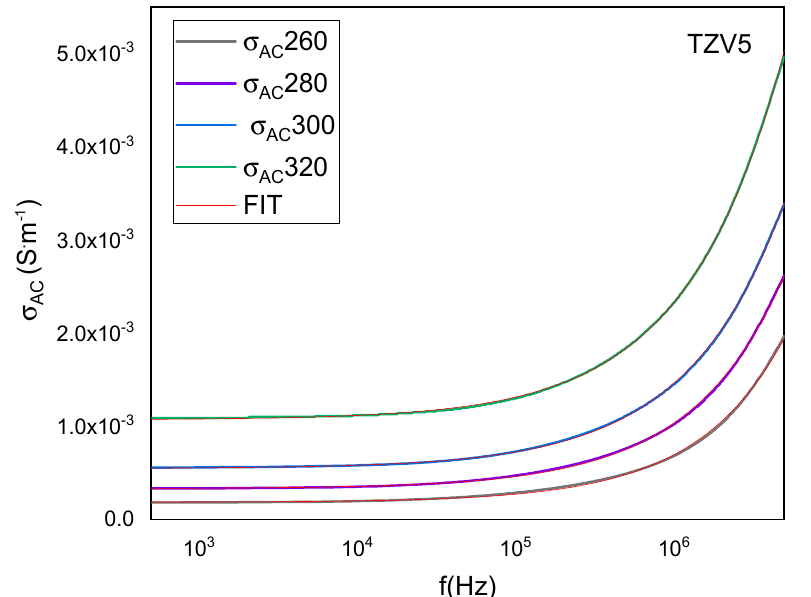
Figure 10. Variation versus frequency of the AC conductivity ( σ AC ) of TZV5 glass at different temper- atures.